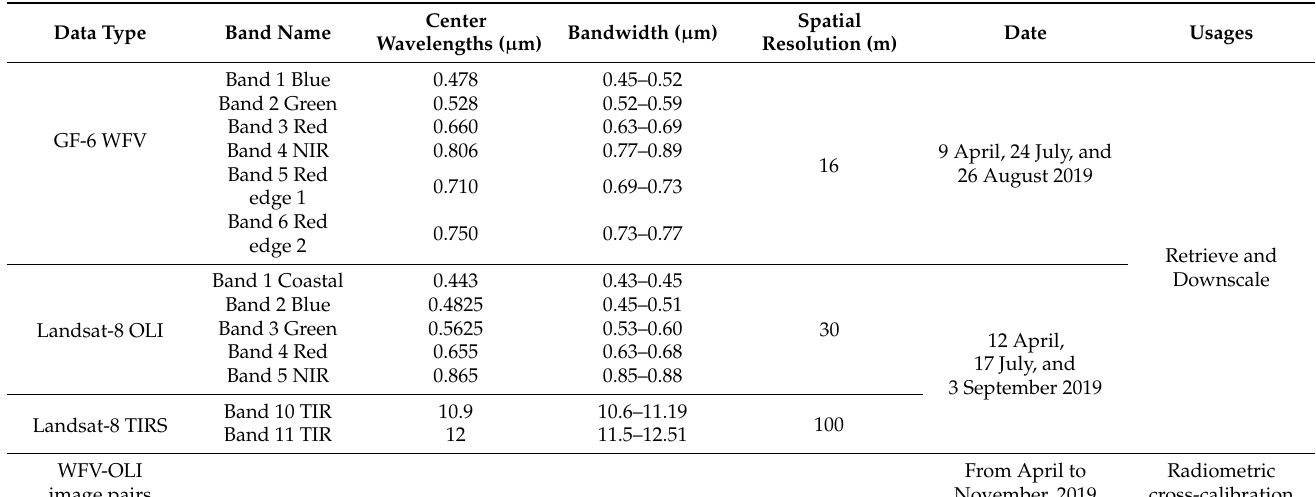
Table 1. Remote sensing images sources.